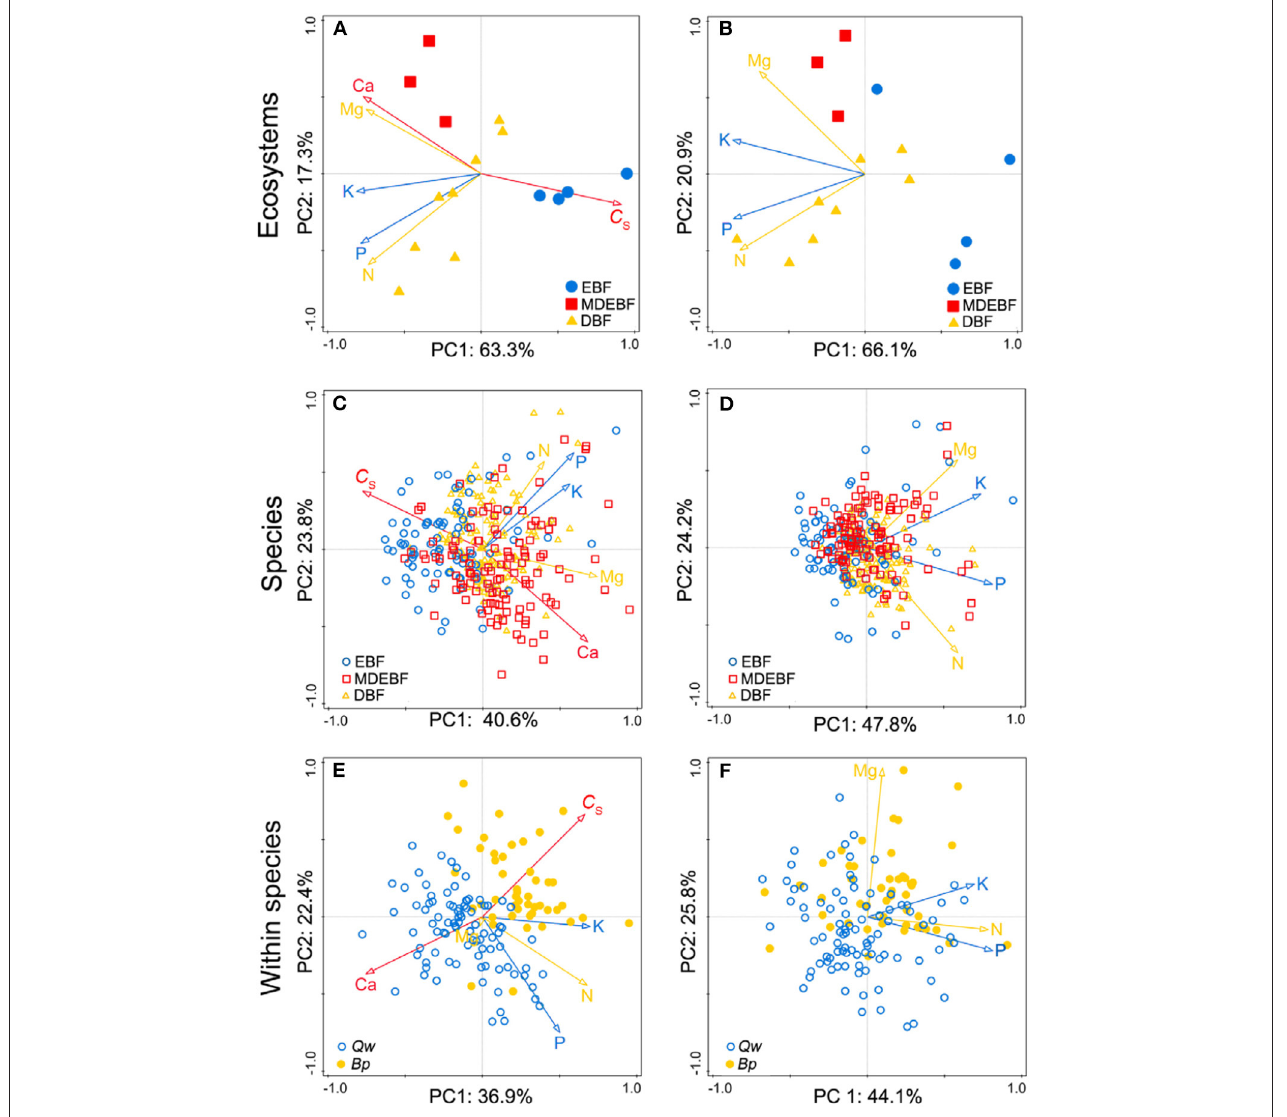
FIGURE 3 | Comparisons between leaf macronutrients with leaf protein-free carbon (C S )-calcium (Ca) (A,C,E) and macronutrients without C S -Ca (B,D,F) across six principal component analyses. The red arrows suggested cell wall-related leaf traits (C S and Ca concentrations), blue arrows showed the protoplasm-related leaf traits [phosphorus (P) and potassium (K) concentrations], and yellow arrows were nitrogen (N) and magnesium (Mg) concentrations. Samples of species by site from EBF/MDEBF/DBF were displayed by open circles/squares/triangles in green/blue/yellow colors (C,D) . Individuals of Quercus wutaishanica (Qw), Betula platyphylla (Bp) were displayed by open/filled circles in green/yellow colors (E,F) . Abbreviations of sample groups are described in Figure 1 . Numeric values in axis labels show the percentage of total variance explained by each